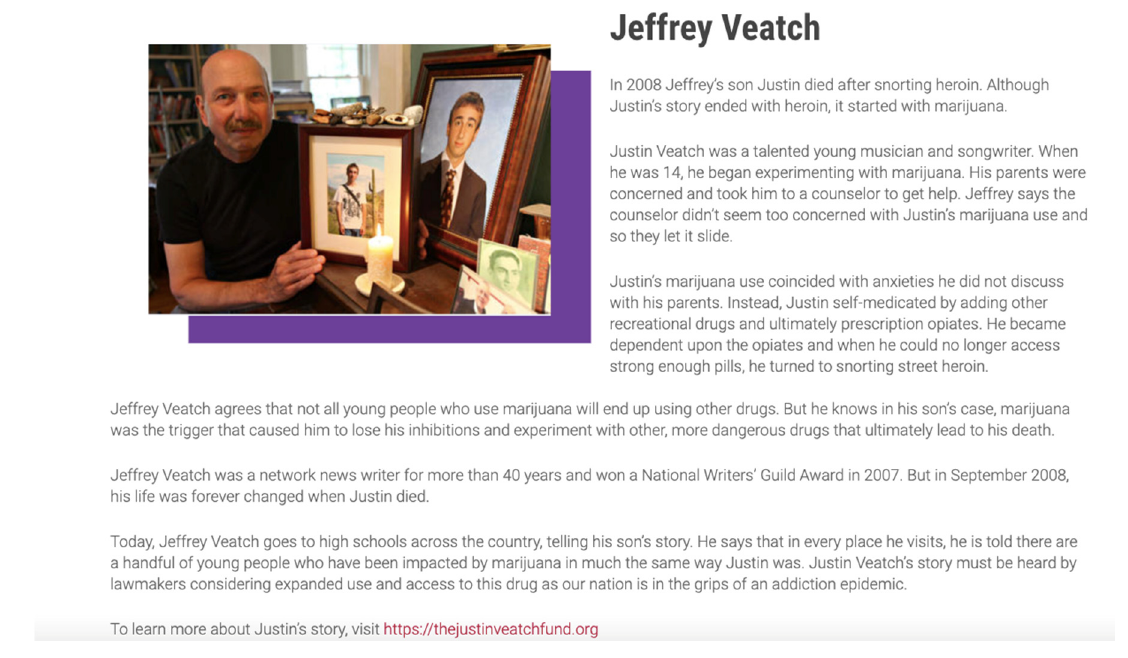
Figure 4. SAM website “The Victims of Marijuana” page (https://learnaboutsam.org/victim-stories/, accessed on 2 November 2021).